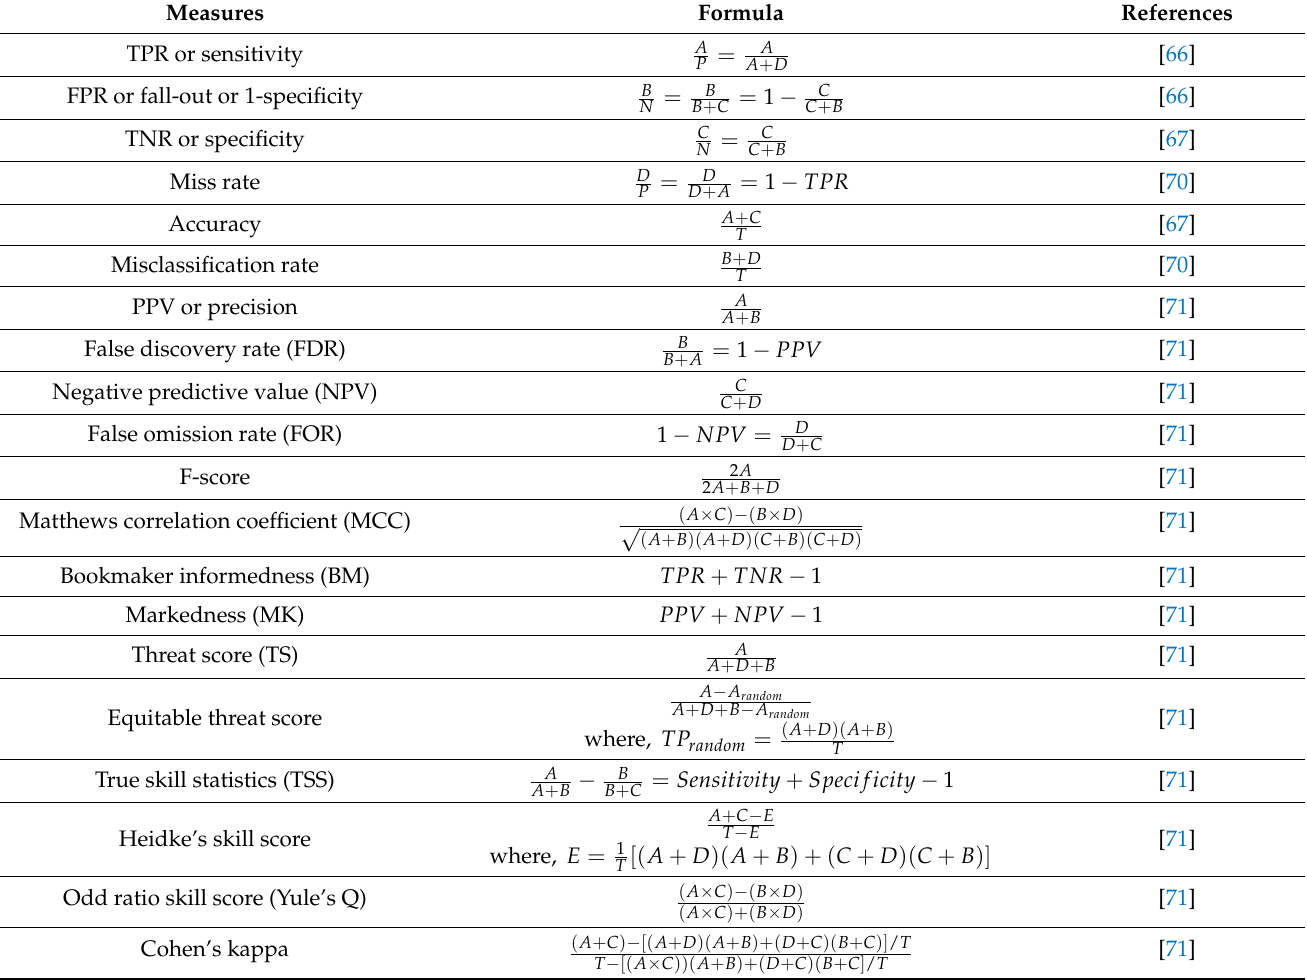
Table 3. Formulas for the computation of statistical accuracy